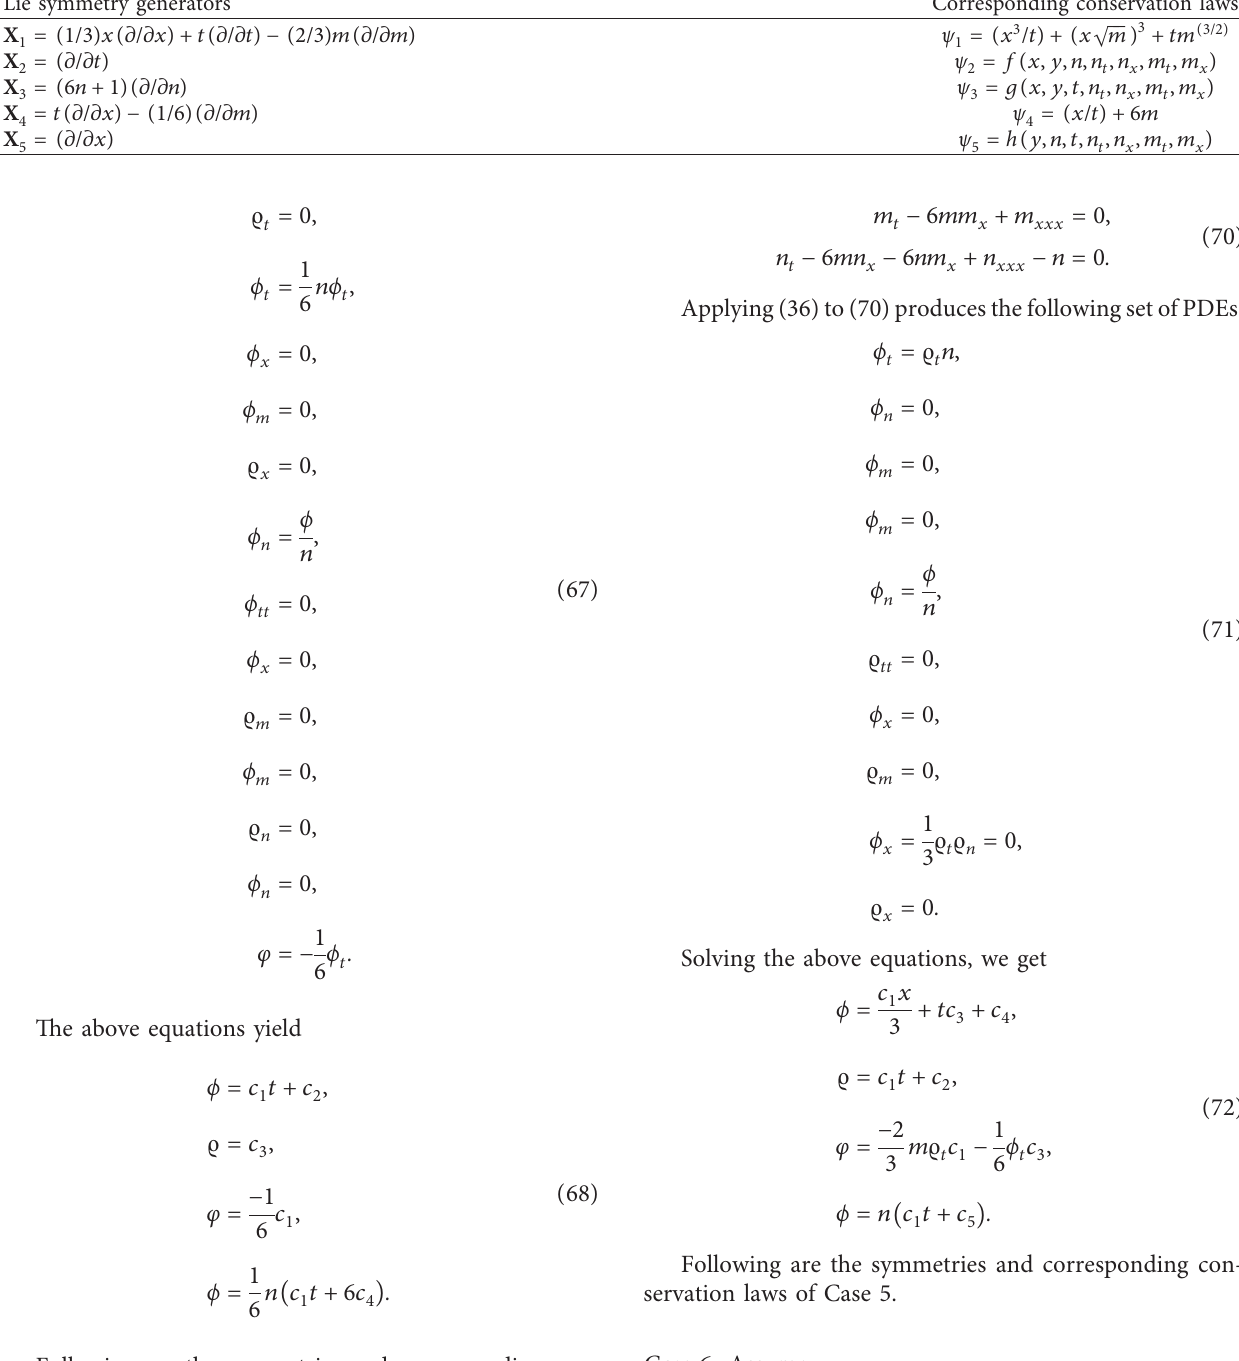
Table 4: Lie symmetry generators and corresponding conservation laws. Lie symmetry generators Corresponding conservation